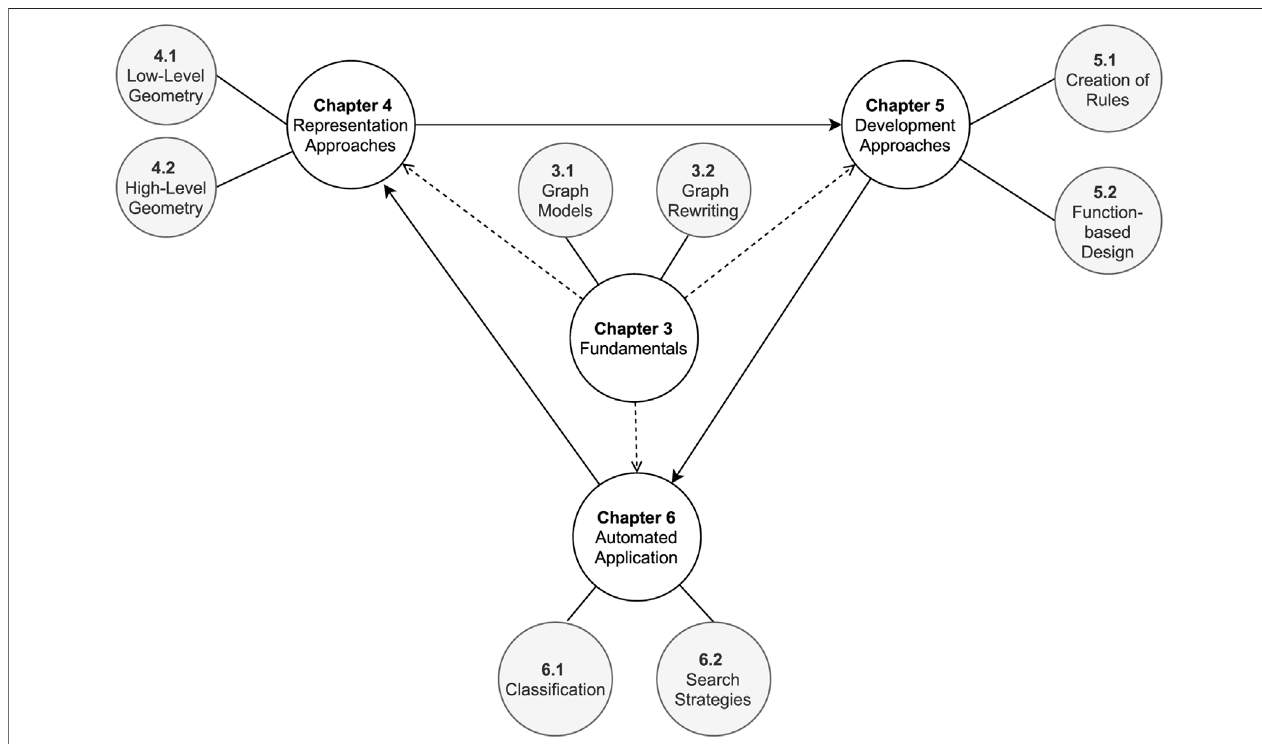
FIGURE 1 | Visualized outline of the review, following the cycle inherent to rewriting methods: The representation of a problem, the formulation of rules, and the application of rules.